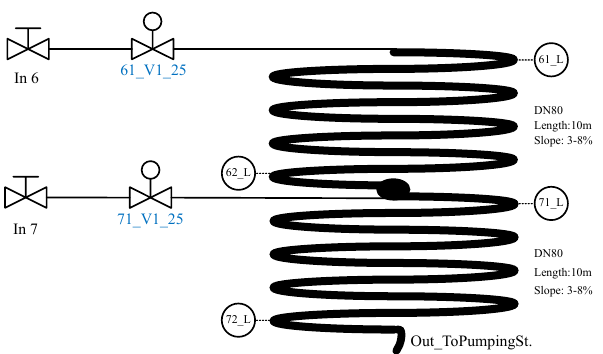
Figure A4. Piping and instrumentation diagram of the sewer pipe unit. The legend is shown in Figure A1 and the details for each component are listed in Table A1.